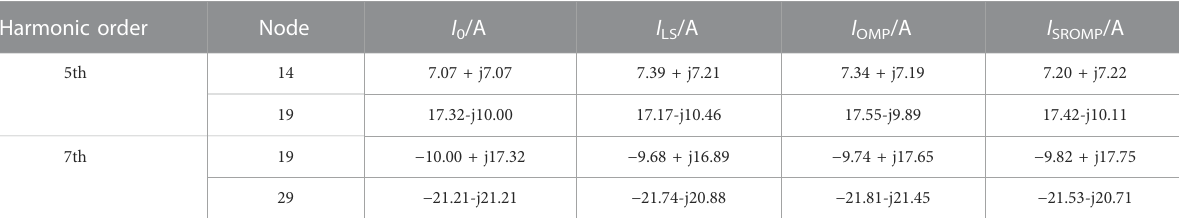
TABLE 1 Harmonic injection current estimation results. Harmonic order